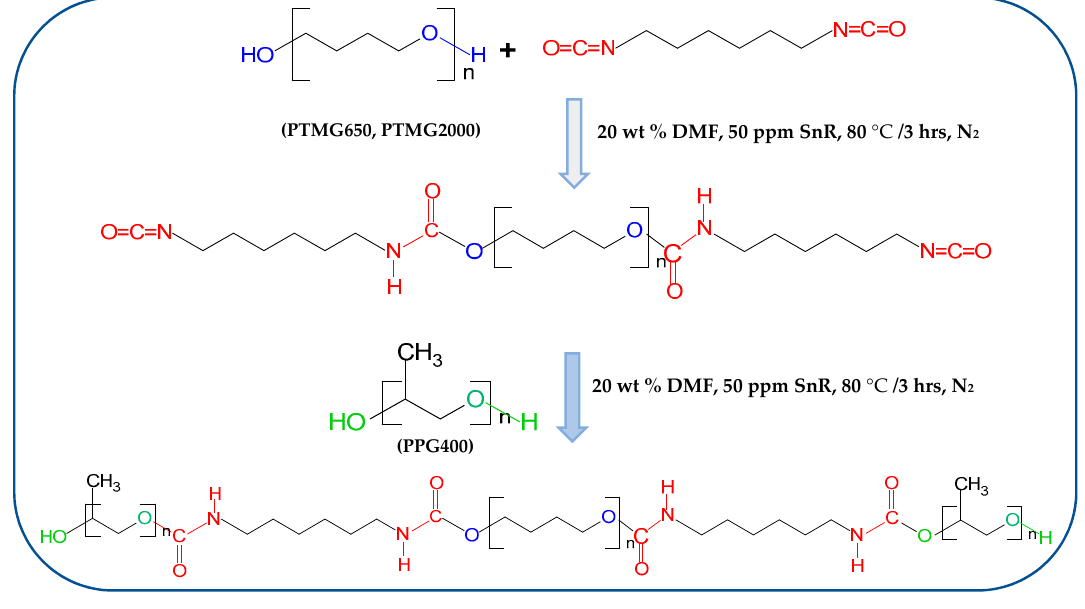
Figure 1. Synthetic pathway of tetra-carbamates. Table 1. Chemical components for the samples.